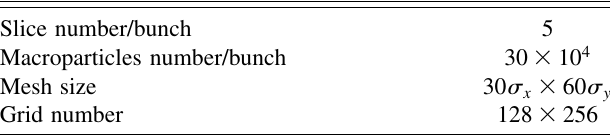
TABLE II. Model parameters. Slice number/bunch Macroparticles